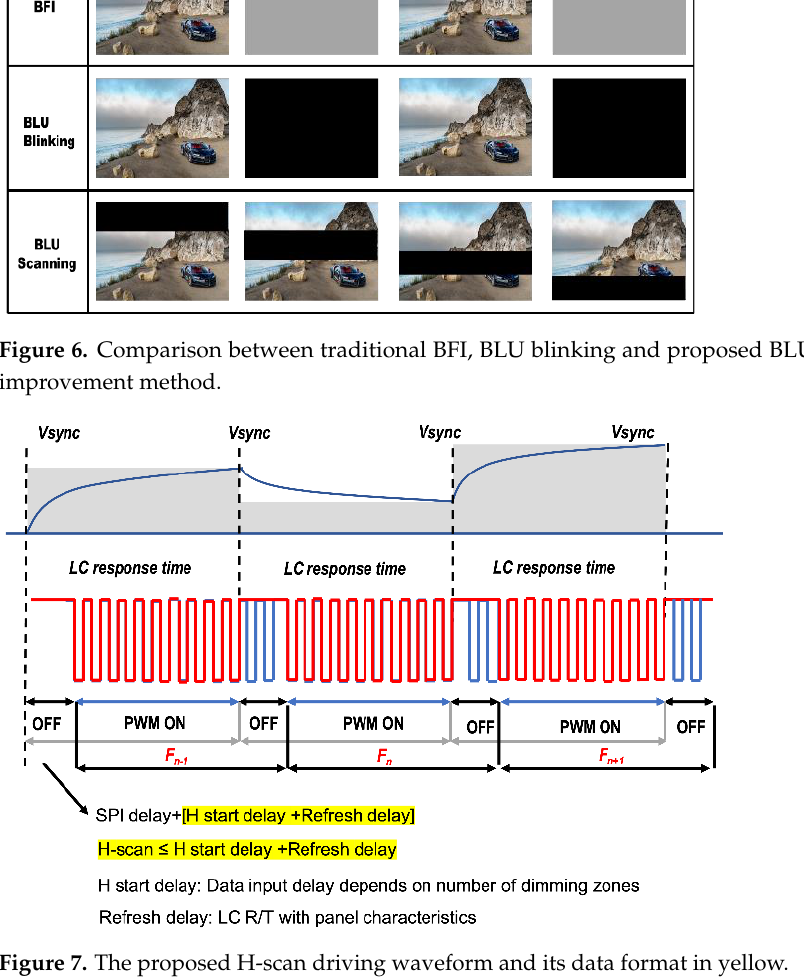
Figure 7. The proposed H-scan driving waveform and its data format in yellow.